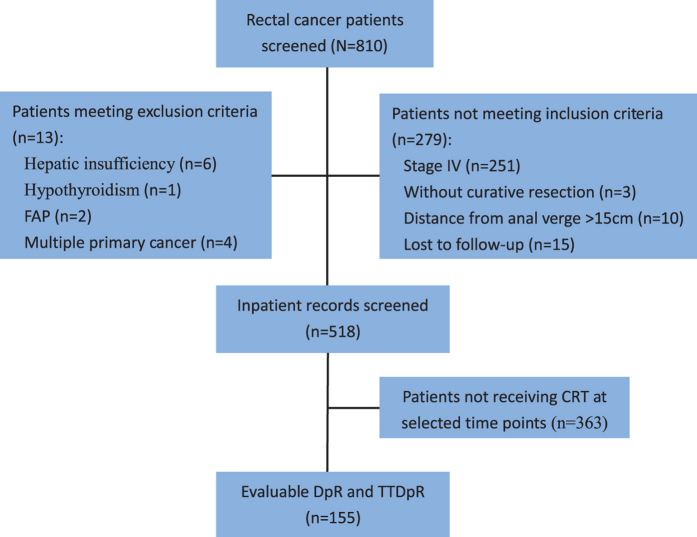
Patient disposition in the analysis of the effect of DpR and TTDpR on survival in rectal cancer.